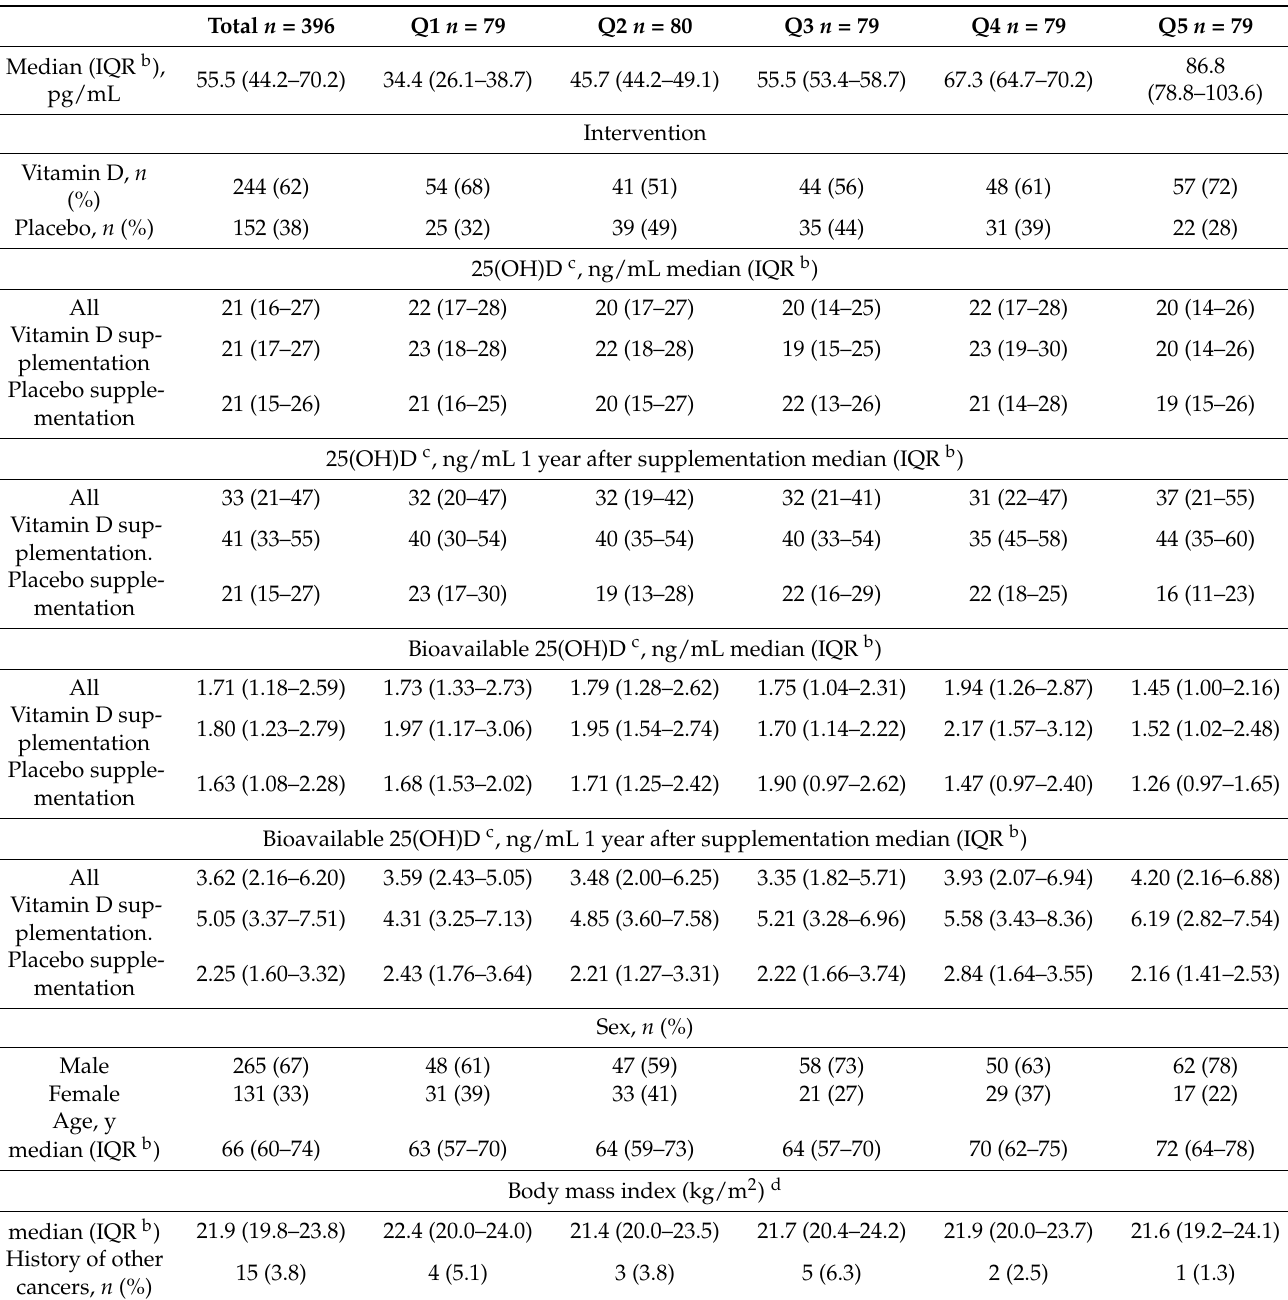
Table 2. Patients’ characteristics in subgroups stratified by quintiles of serum PD-L1